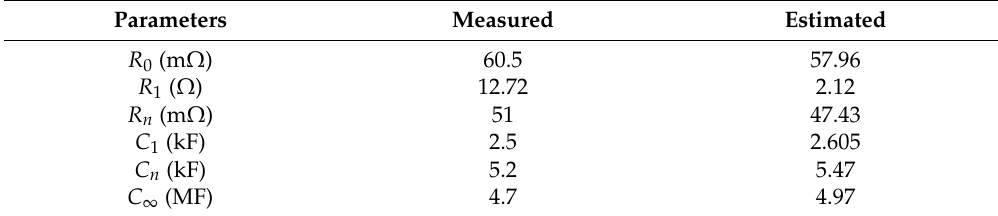
Table 17. Results of Case 4 for Pb.